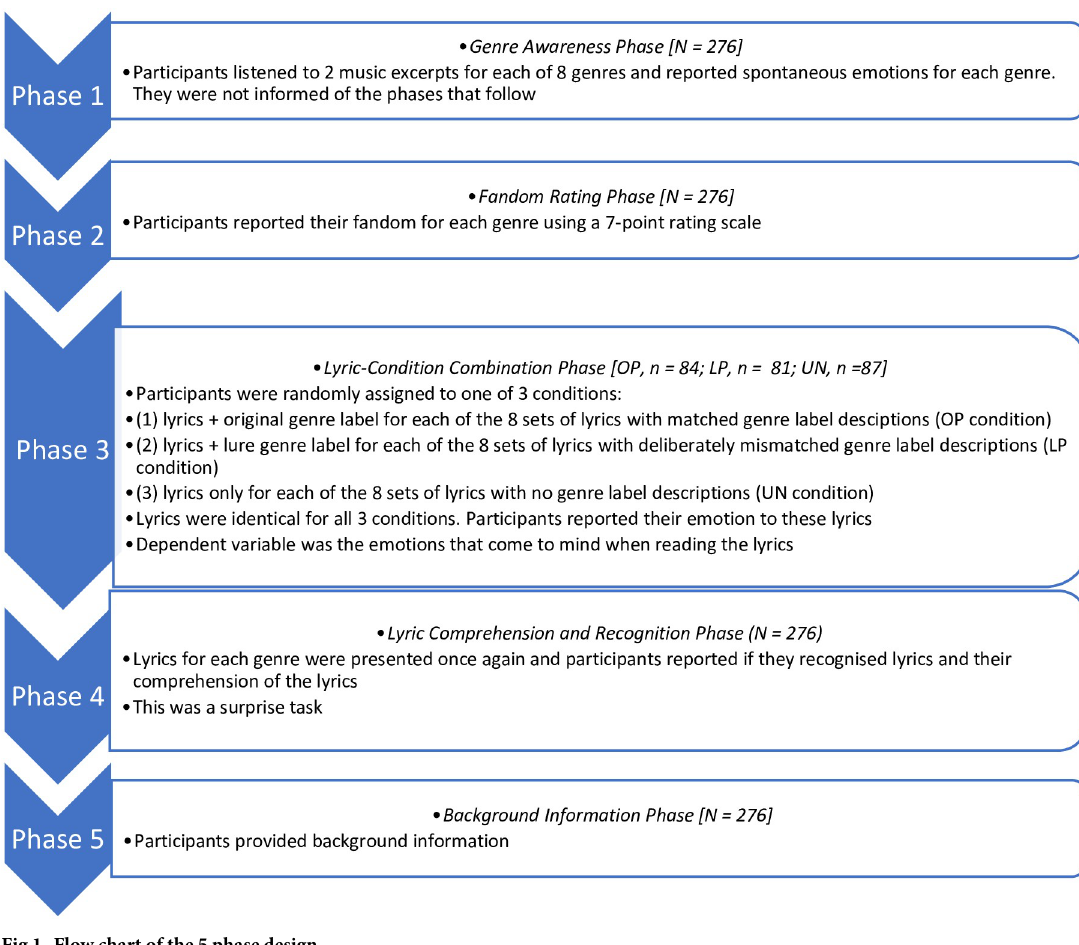
Fig 1. Flow chart of the 5 phase